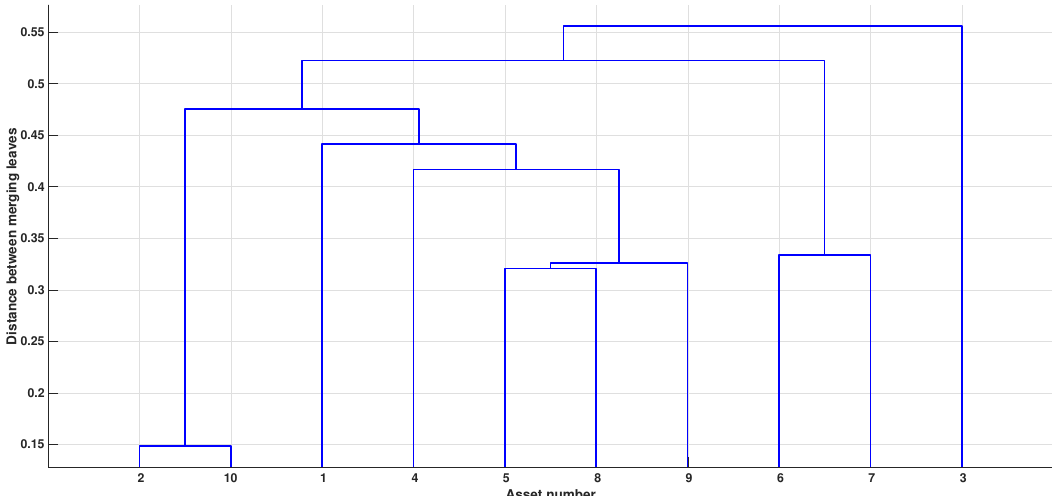
Figure 1. A Sequence of clusters formed in hierarchical clustering represented as a dendrogram with y-axis representing the distance between the two merging